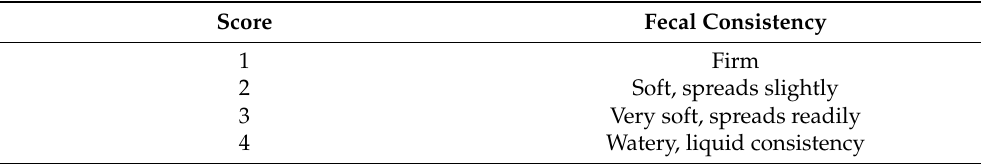
Table 1. The scoring scale that was followed for the scoring of fecal consistency during the first week of the post-weaning period on a pen basis. Score Fecal Consistency 1 Firm 2 Soft, spreads slightly 3 Very soft, spreads readily 4 Watery, liquid